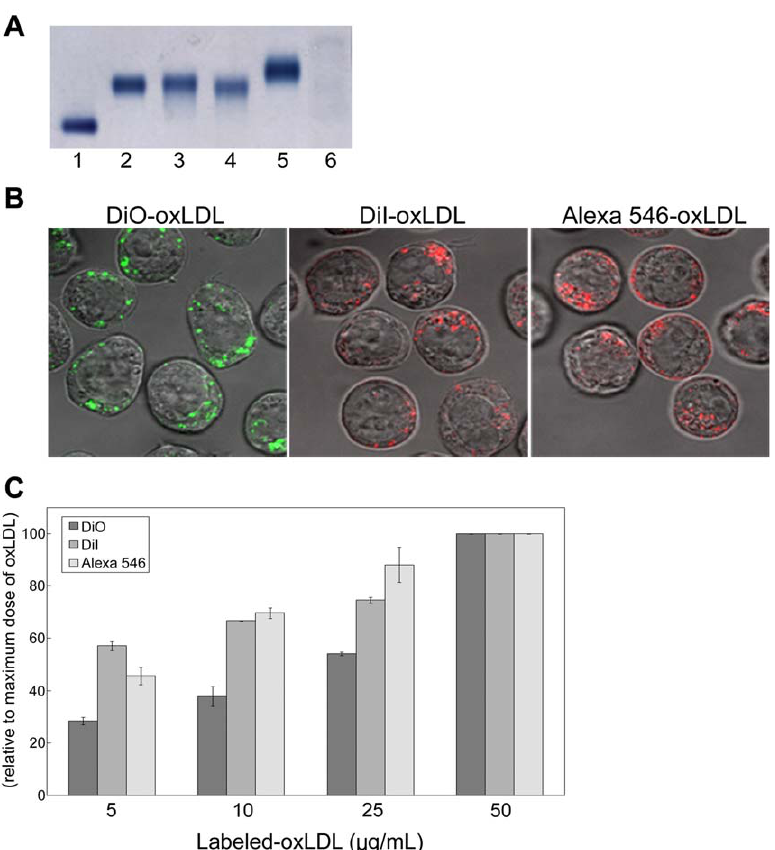
Figure 1. Characterization of oxLDL labeling and uptake by U937 cells. ( A ) Migration of fluorescently labeled oxLDL analyzed by agarose gel electrophoresis: lane 1: native LDL, lane 2: oxLDL, lane 3: DiI-oxLDL, lane 4: DiO-oxLDL, lane 5: Alexa 546-oxLDL, lane 6: LPDS. ( B ) Uptake of fluorescently labeled oxLDL. U937 cells were treated with labeled oxLDL: DiO-oxLDL, DiI-oxLDL, or Alexa 546-oxLDL (24 m g/ml) for 5 h then fixed with 4% formaldehyde and visualized in sealed capillaries using confocal microscopy. ( C ) FACS analysis showing dose-dependent uptake of labeled oxLDL 90 min post treatment in U937 cells. Each data point represents the mean 6 range of duplicate determinations (1 6 10 4 cells/determination), and data presented are representative of four independent